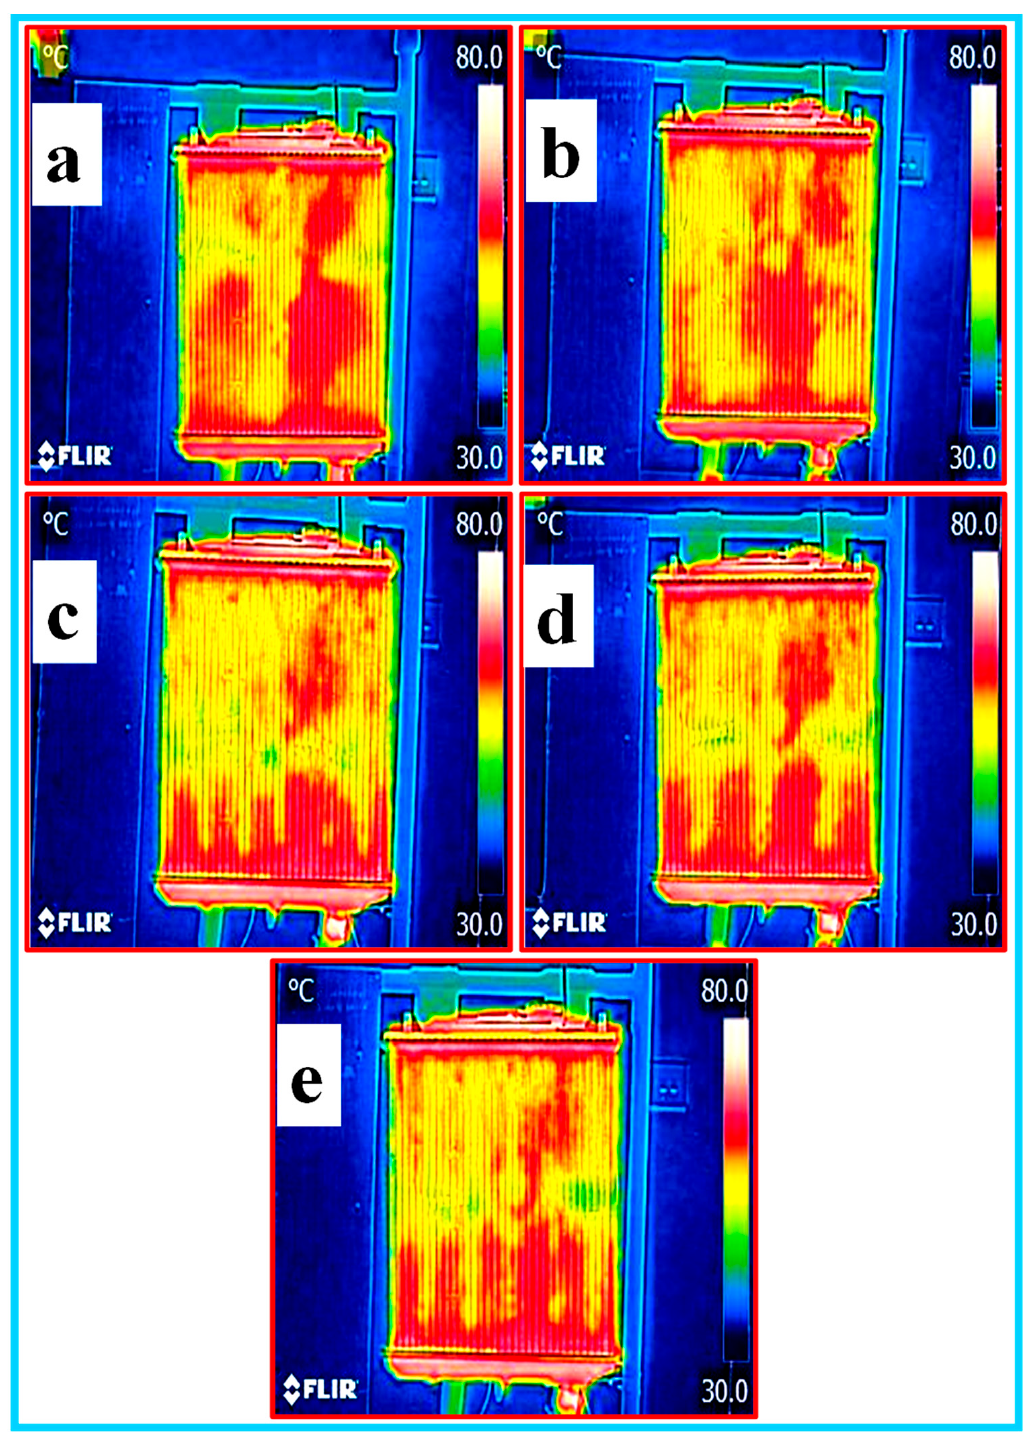
Figure 13. Thermal imaging of the base fluids (ethylene glycol–water mixture (EG–W)) in the radiator ( a – e ).